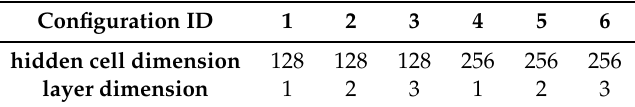
Table 5. LSTM configuration